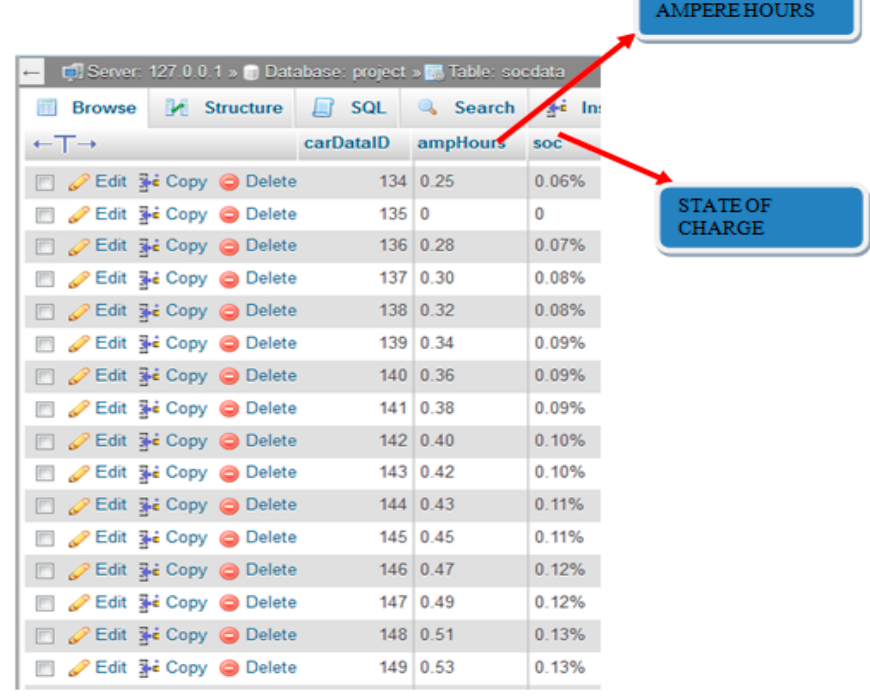
Figure 15. Database of SOC data.